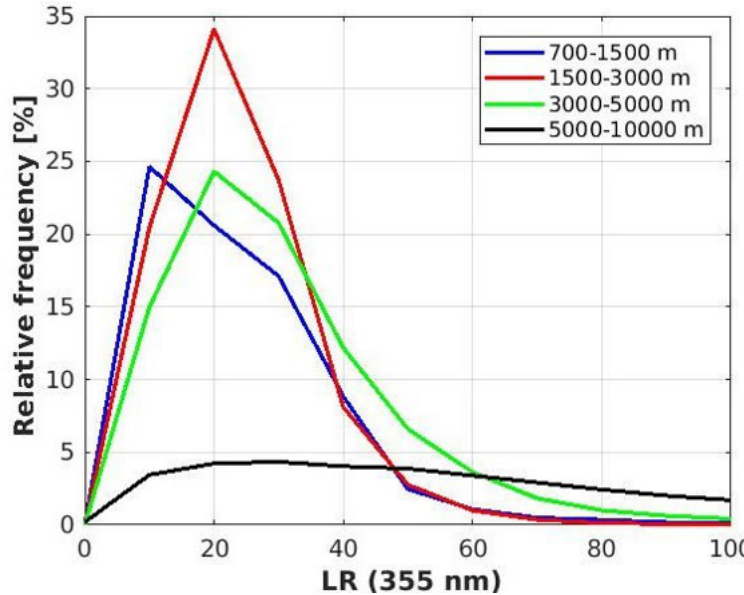
Figure 7. January–April: Frequency of the LR 355